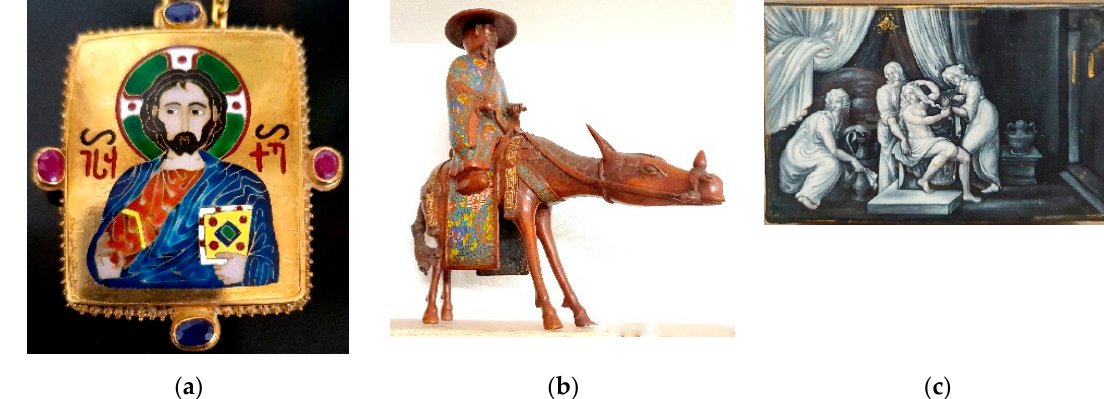
Figure 1. Examples of decorative enameled objects preserved and exhibited at the ARtCHIVIO museum in Ponte San Pietro (BG), Italy: ( a ) cloisonné enamel on gold icon in byzantine style, end of 20th century; ( b ) Champlevé enamel on bronze two-pieces statue, end of 19th century; ( c ) Enamel peint representing “Psyche’s toilet” by Jules Sarlandie, end of 19th century. Image courtesy of ARtCHIVIO museum, Ponte San Pietro (BG), Italy.